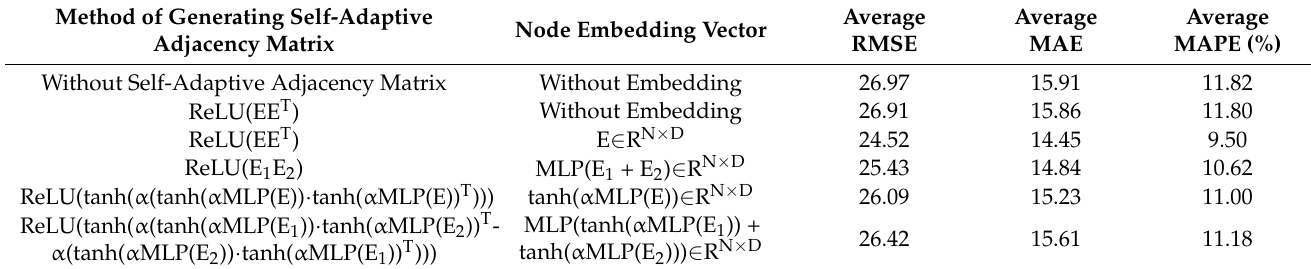
Table 4. Influence of the adaptive adjacency matrix construction method on prediction (with PeMS08 as an example).